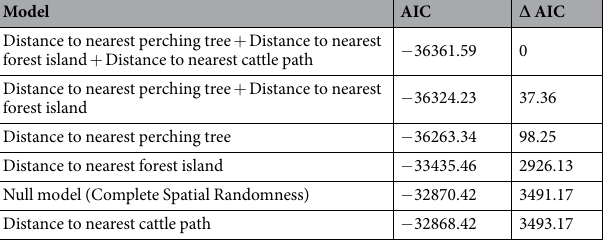
Table 2. Models obtained to relate the spatial distribution of the immature Motacú palms with the spatial covariates related with the dispersers (distance to nearest perching tree for macaws, distance to cattle paths) and the source of seeds (distance to nearest forest island).